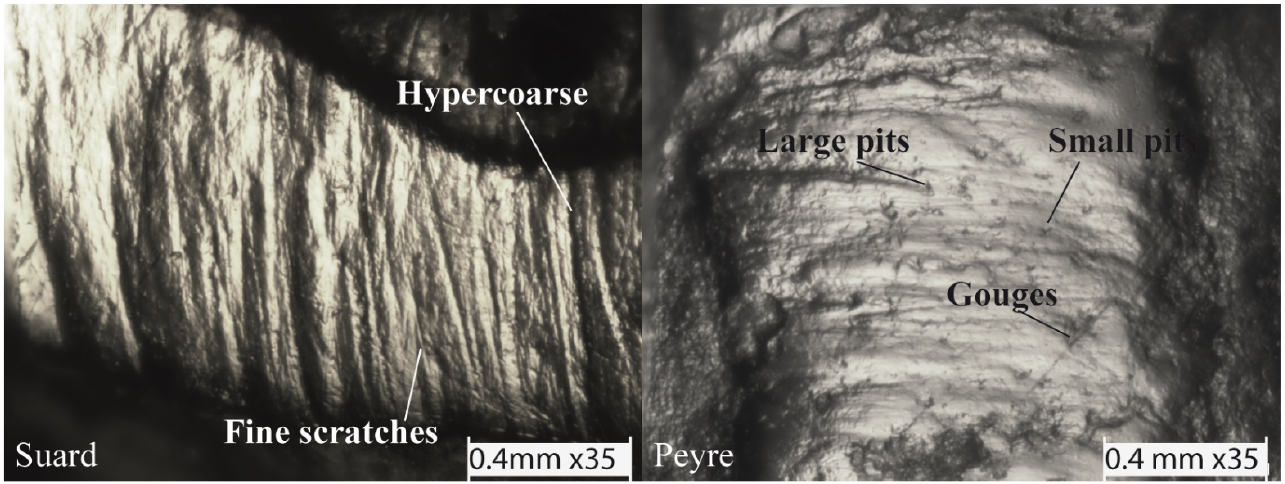
Figure 2. Photomicrographs of horse teeth from Suard (n° 52-K14-50) and Peyre (n° E9-347) with scratches and pits. Magnification ×35.